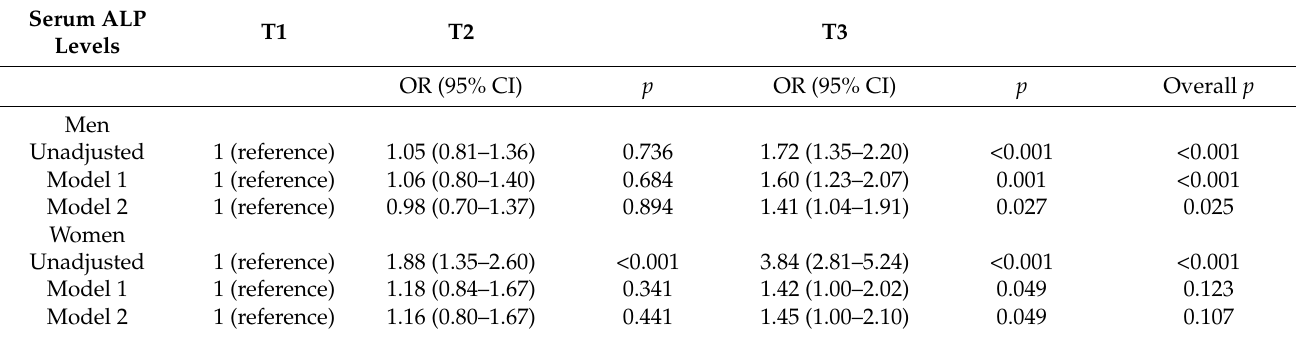
Model 1: Adjusted for age and body mass index. Model 2: Adjusted for variables included in Model 1 plus smoking status, heavy alcohol drinker, physical activity, total calorie intake, and number of chronic diseases. Abbreviations: ALP, alkaline phosphatase; CI, confidence interval; LSMI, low skeletal muscle mass index; OR, odds